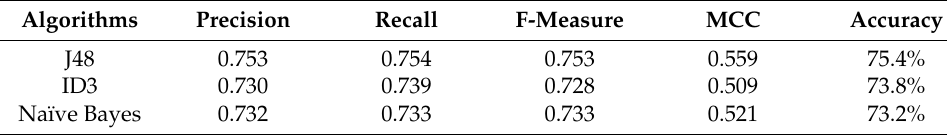
Table 4. Accuracy values obtained for ID3, Naïve Bayes and